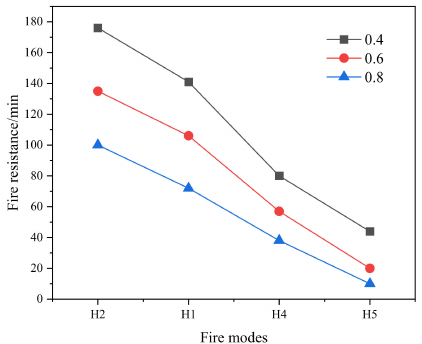
Figure 10. Curves of the effect of different fire modes on the fire resistance of